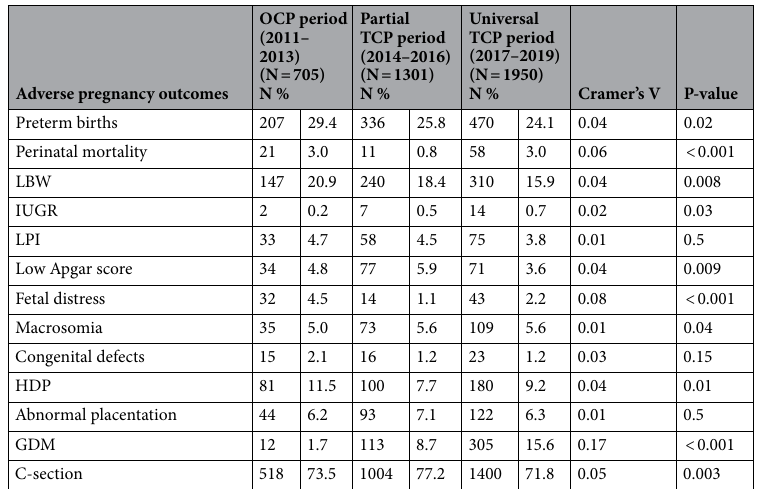
Table 4. Changes of adverse pregnancy outcomes in women with AMA over the period of policy changes. OCP (One-child policy), TCP (Two-child policy), AMA (advanced maternal age), LBW (low birth weight),